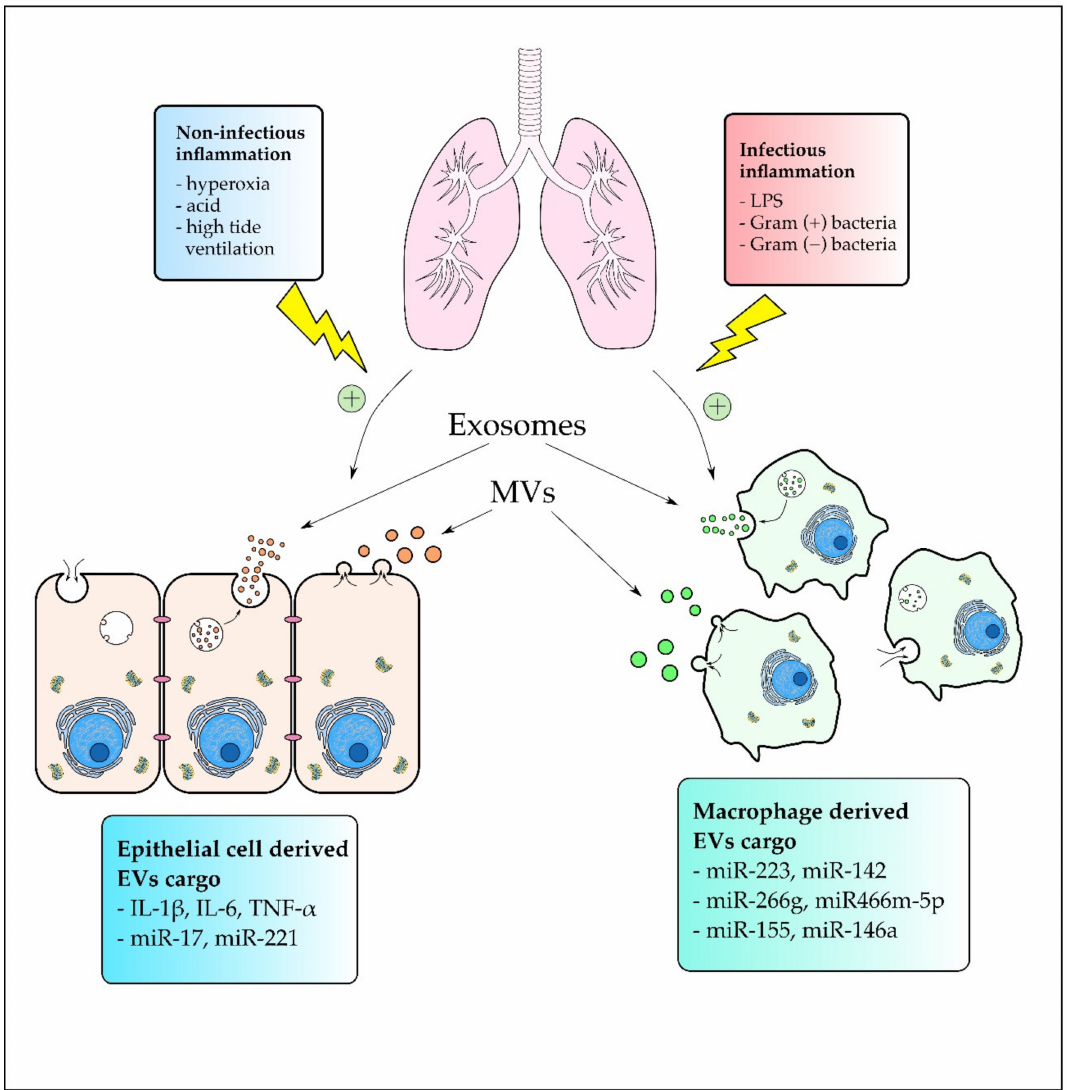
Figure 1. The effect of infectious and noninfectious stimuli on extracellular vesicle (EV) release during acute lung injury (ALI)/acute respiratory distress syndrome (ARDS) development. Noninfectious stimuli mainly induce EV production and release by alveolar epithelial cells, whereas infectious stimuli were correlated mainly with alveolar macrophage (AM) activation and AM-EV